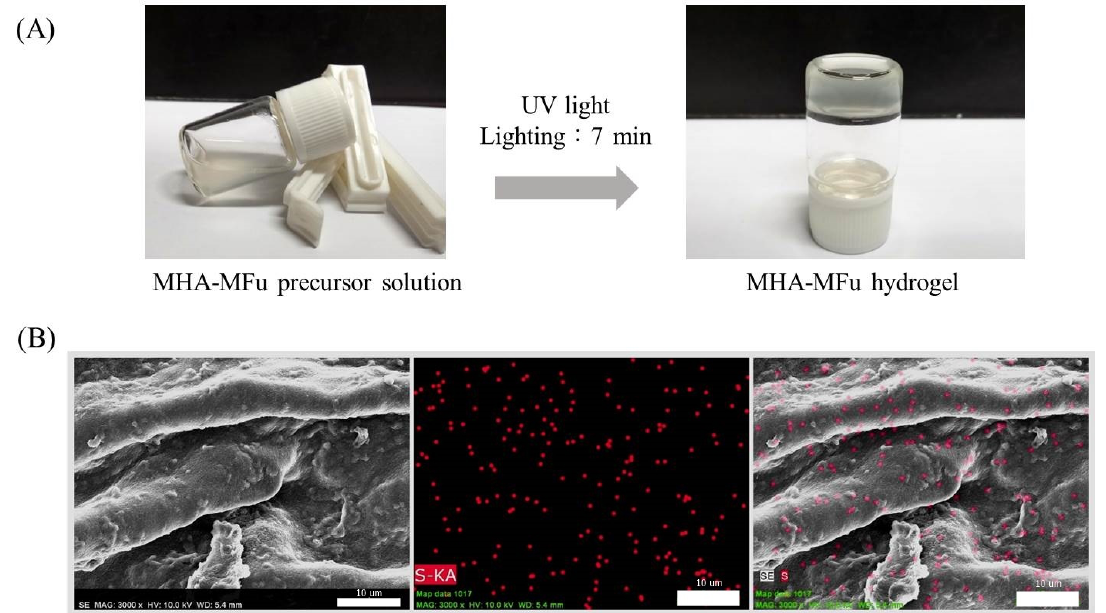
Figure 1. Hydrogel formation ( A ) and SEM images of elemental mapping of sulfur (S) in the MHA-MFu hydrogel ( B ). Scale bar = 10 μ m.